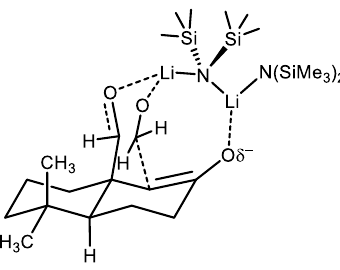
Figure 6. Chelating transition structure. Molecules 2020 , 25 , 831 7 of 14